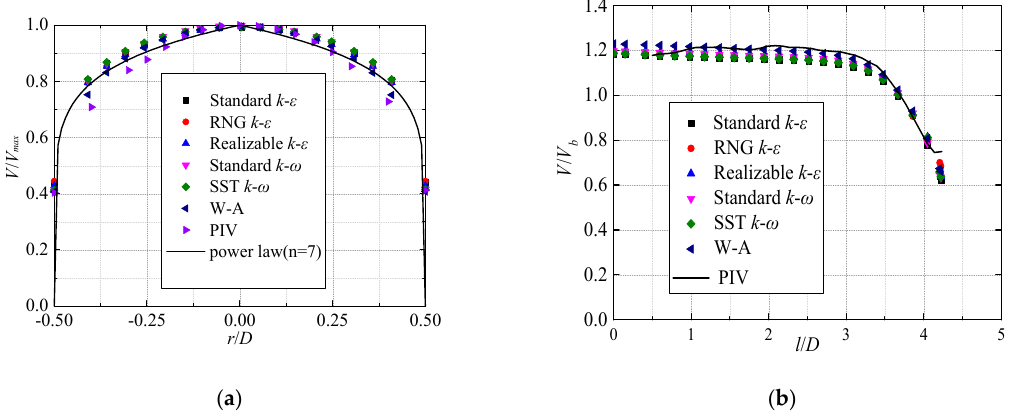
Figure 3. Verification of Wray-Agarwal turbulence model: ( a ) Profiles of the normalized axial velocity V / V max near the jet exit; ( b ) Normalized mean axial velocity V / V max profiles along the centerline of the impinging jet.